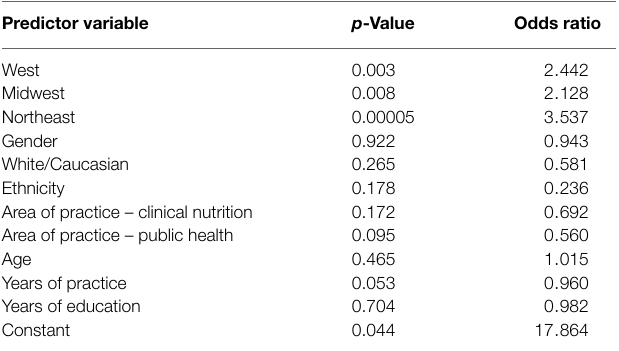
TABLE 3 | Number and percentage of survey participants that engage in activities that promote diet as a climate change mitigation strategy based upon being vegetarian a,b,c .